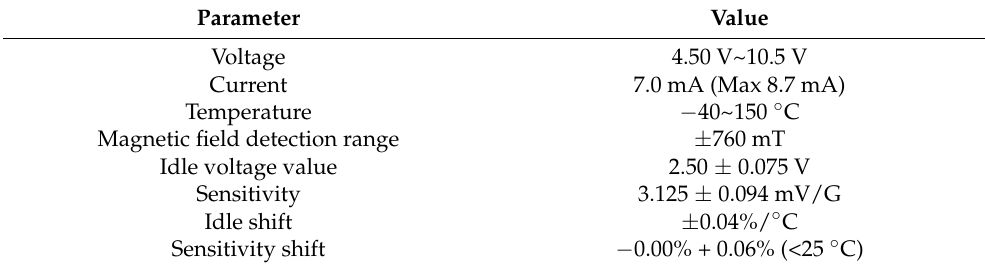
Table 2. Permanent magnet parameter setting table.